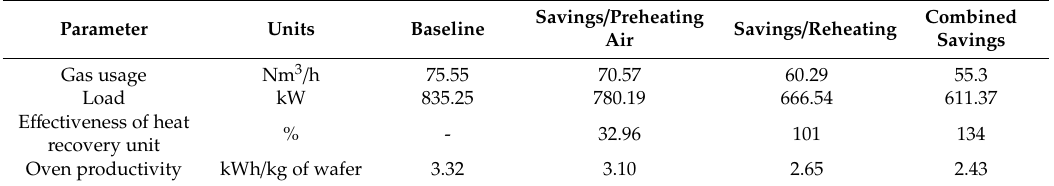
Table 9. Key performance indicators of the industrial-scale baking oven before and after heat recovery to preheat combustion air and reheat returning process water.